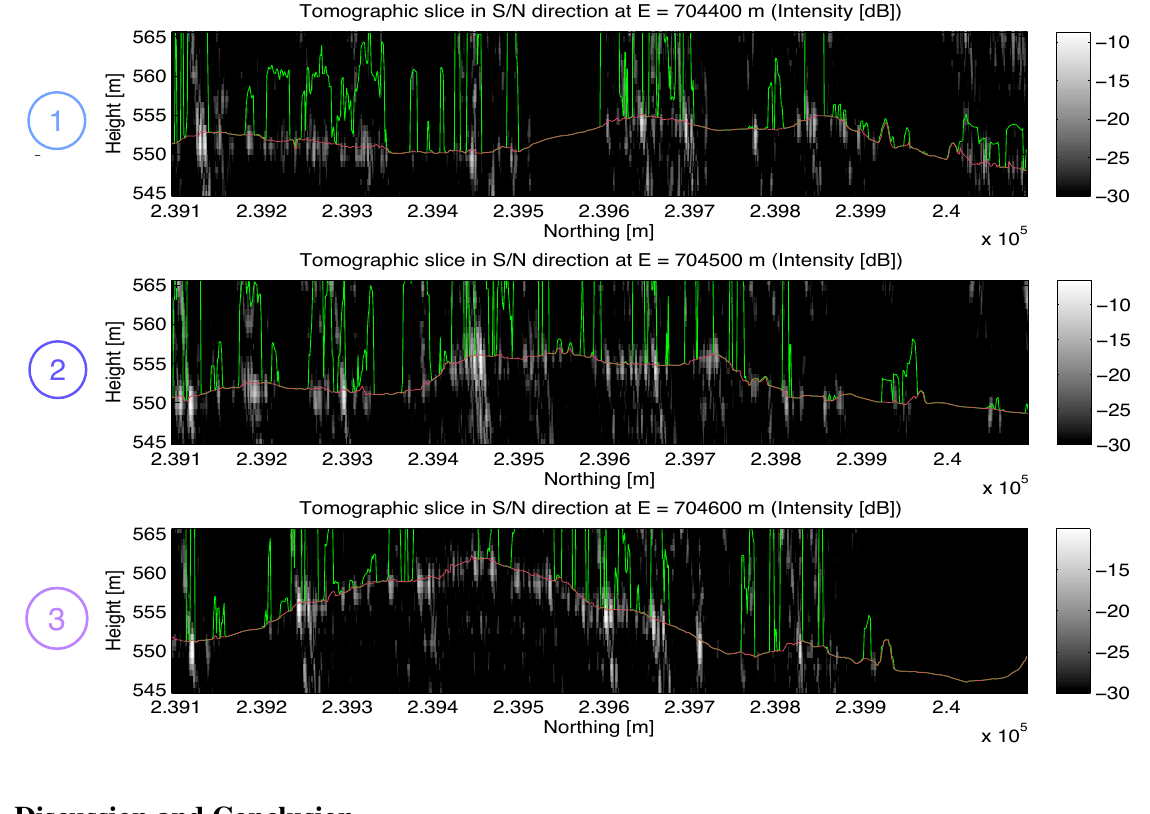
Figure 5. Vertical slices of the SAR tomographic image in south-northern direction. Red/green lines in the tomographic slices: High resolution DEM/DSM from airborne laser scanning (Falcon II, TopoSys GmbH) indicating the ground level and canopy height as a